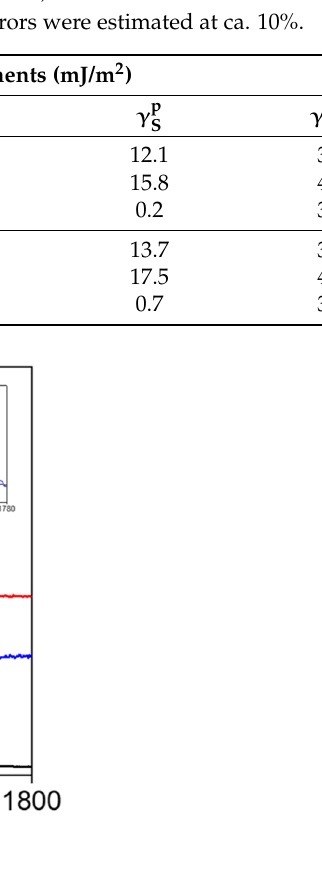
Figure 6. Micro-Raman spectra ( λ exc = 532 nm) of non-irradiated PET and PET irradiated with UV and NIR wavelengths. Spectra were shifted vertically for the sake of comparison. The inset shows magnification of the region around 1720 cm − 1 for PET and PET irradiated with UV pulses (in this case, spectra were base ‐ line corrected and normalized).